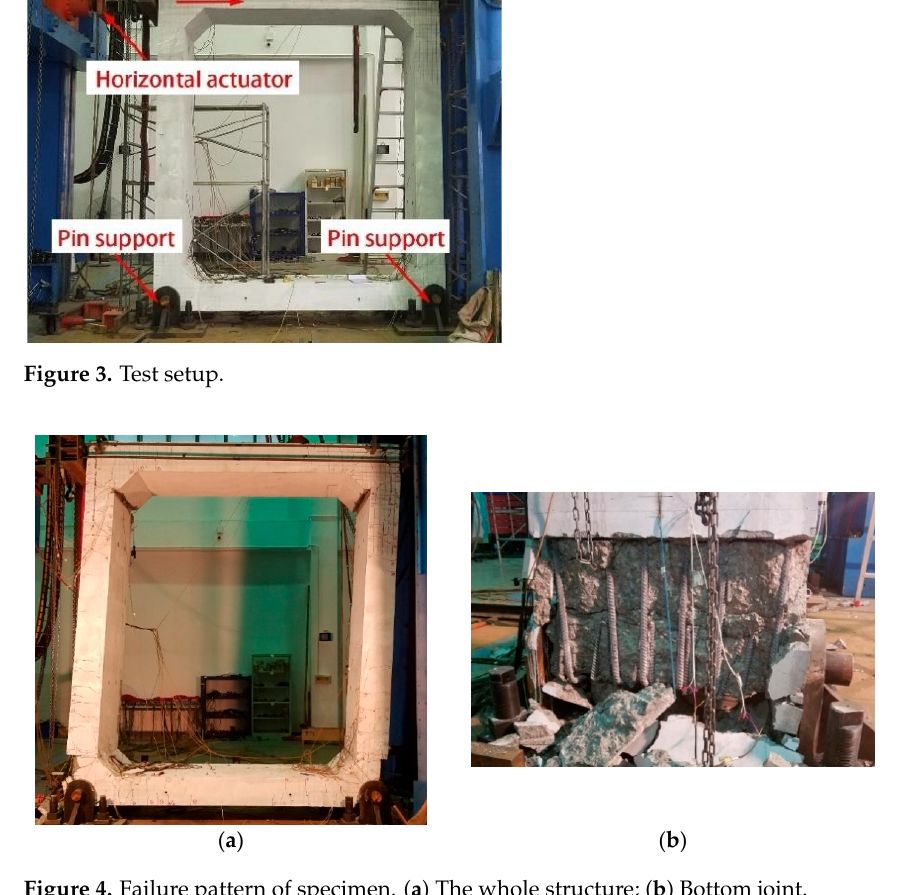
Figure 4. Failure pattern of specimen. ( a ) The whole structure; ( b ) Bottom joint.